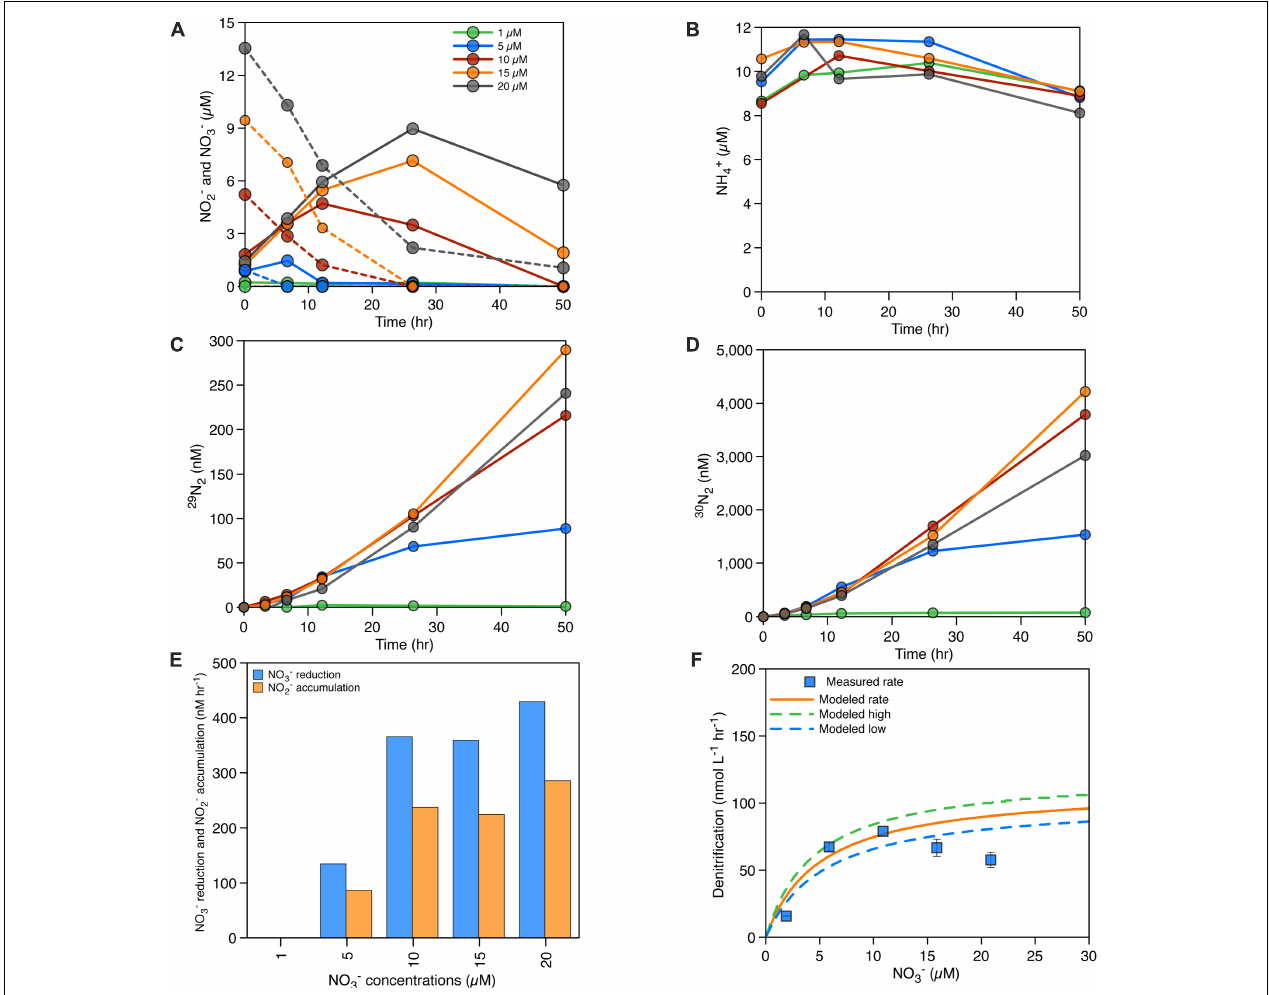
FIGURE 4 | (A) NOx accumulation/consumption over time with the addition of different NO 3 − concentrations – NO 3 − concentrations in dashed lines, NO 2 − concentrations in solid lines. (B) NH 4 + accumulation/consumption over time with the addition of different NO 3 − concentrations. (C) Production of 29 N 2 in the incubations (nM). (D) Production of 30 N 2 in the incubations (nM), (E) rates of NO 3 − reduction and NO 2 − accumulation (nM hr − 1 ). (F) Michaelis–Menten curve and measured denitrification rates for different NO 3 − concentrations in August 2015, see Table 2 for details on the Michaelis–Menten parameters used in (F) .